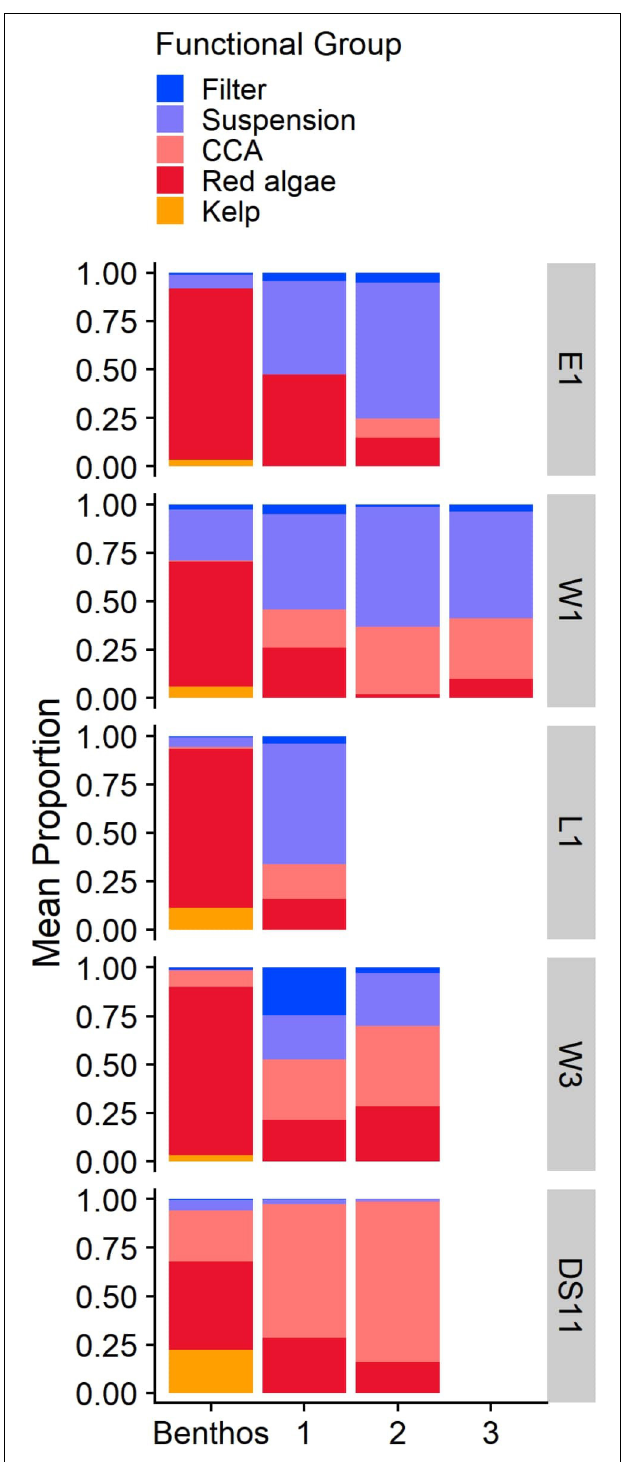
FIGURE 5 | Mean proportion of each functional group at each site based on in situ benthic photoquadrats (Benthos) and settlement tiles by deployment time (1, 2, 3 years). Values represent the proportion of total biotic percent cover for the benthic community (Benthos) and proportional abundance for tile communities. Note that no kelp recruited to settlement tiles. Sites are ordered by distance to river inputs ( Table 2 ).